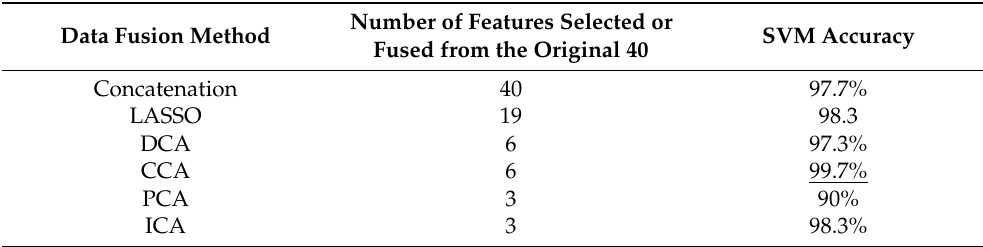
Figure 8. Bar plot showing the accuracy of the SVM when using different feature fusion techniques. Table 2. Comparison between various scenarios. Showing the SVM accuracy for the six different feature analysis techniques.